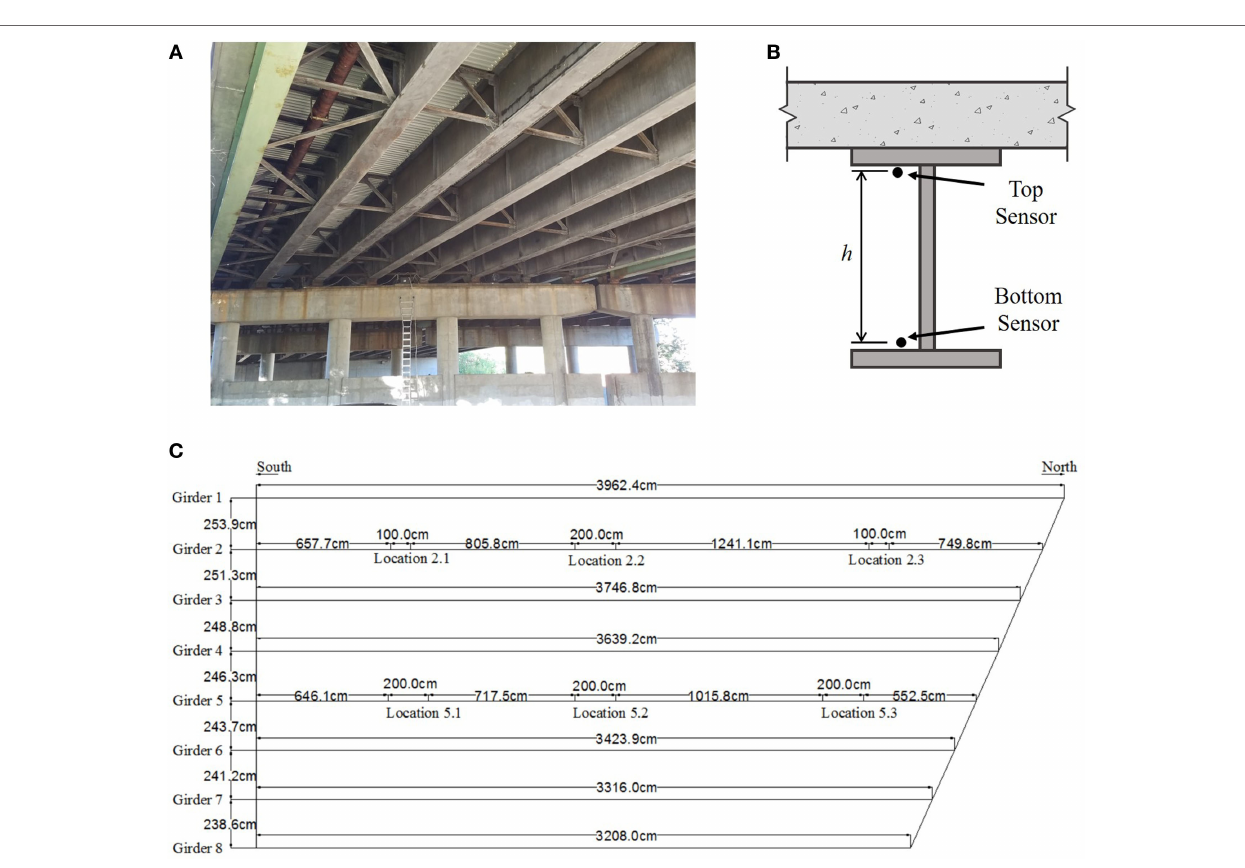
FIGURE 12 | In-service structure utilized in study: (A) View of underside of instrumented bridge span, (B) cross-section of girder with sensor placement, and (C) plan view of bridge span with structure dimensions and sensor layout (Flanigan